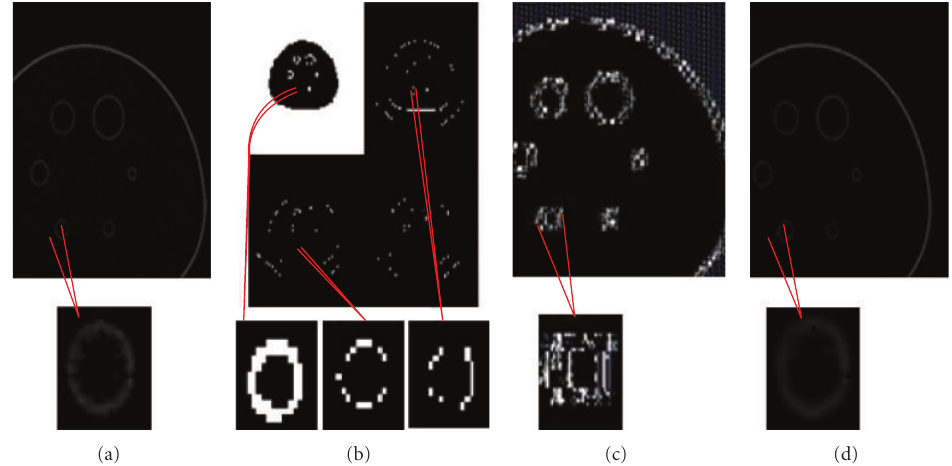
Figure 15: Segmentation using conventional hard thresholding and curvelet-based segmentation. (a) Denoised spatial domain. (b) First level in wavelet domain. (c) Ridgelet domain. (d) Curvelet